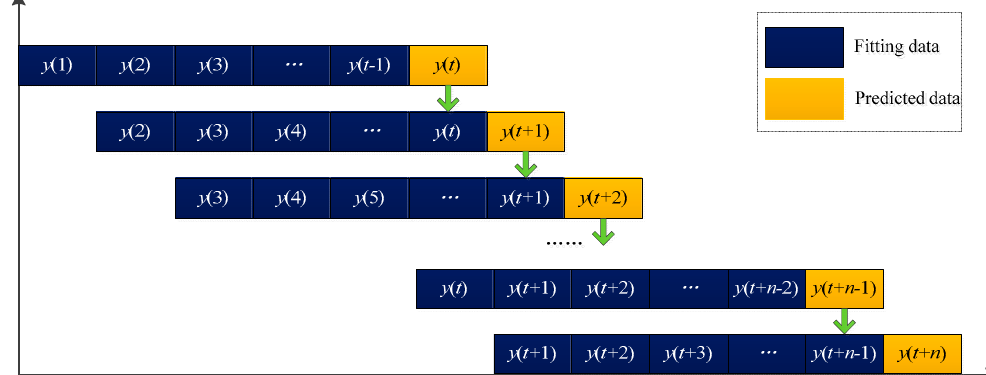
Figure 3. The trend extrapolation method of energy demand influencing factors.